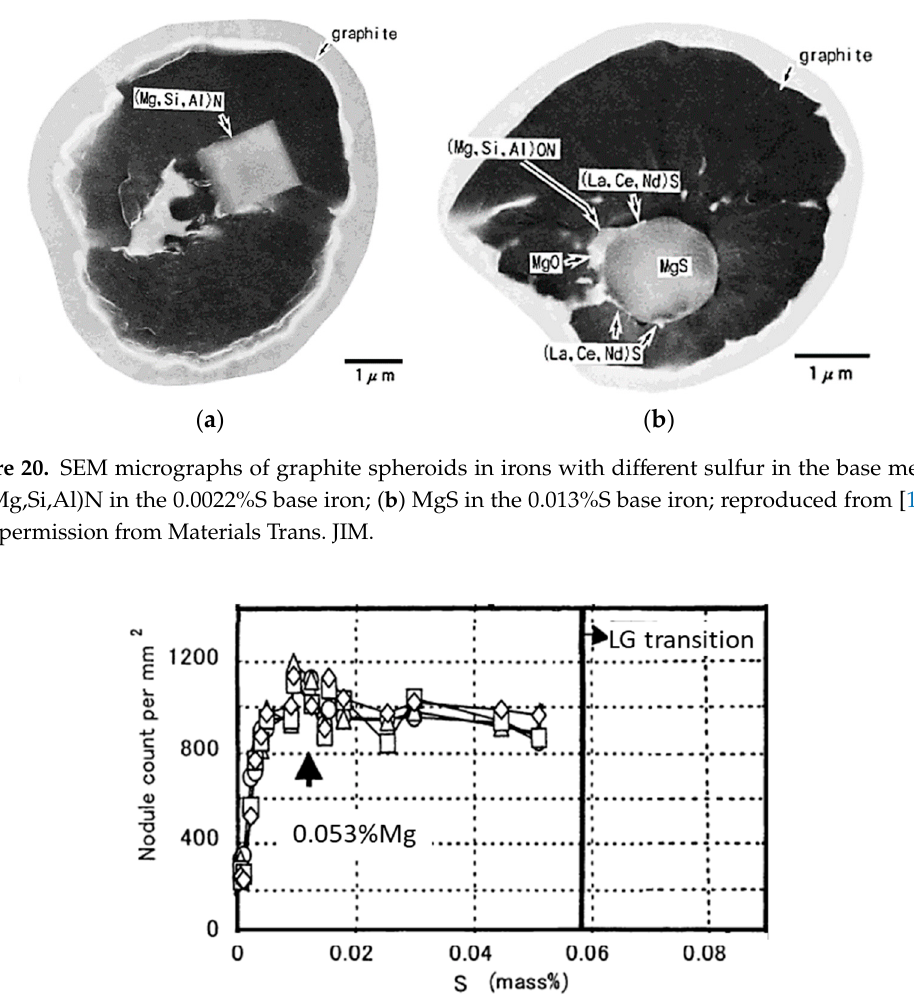
Figure 23. SEM image of Ti-Zr carbonitride and composition map showing Ti and N concentration at the corner and faces of the inclusion (carbonitride) and Mg, Ca, S and O in the middle of the inclusion (oxysulfide) in a sample produced from a 0.03% Ti iron inoculated with a ZrMn inoculant; the presence of Zr was confirmed through the X-ray concentration graph. See Reference [106] for experimental conditions.